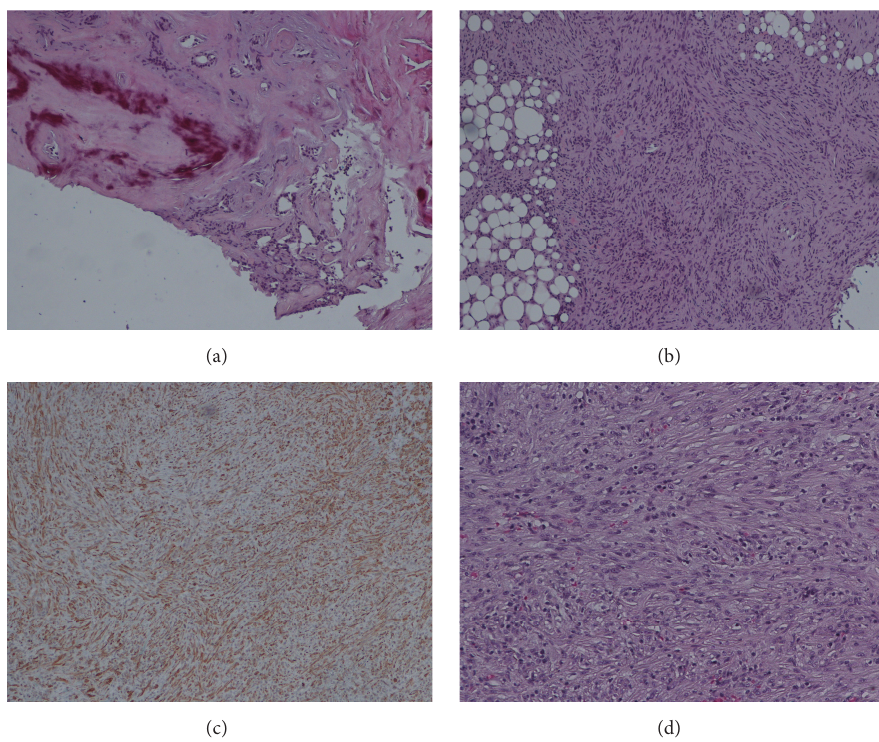
Figure 2: 100x magnification of (a) calcifications around benign glandular tissue, (b) spindle cells infiltrating periparotid adipose tissue, and (c) smooth muscle stain of parotid lesion being positive. 200x magnification of (d) spindle cell